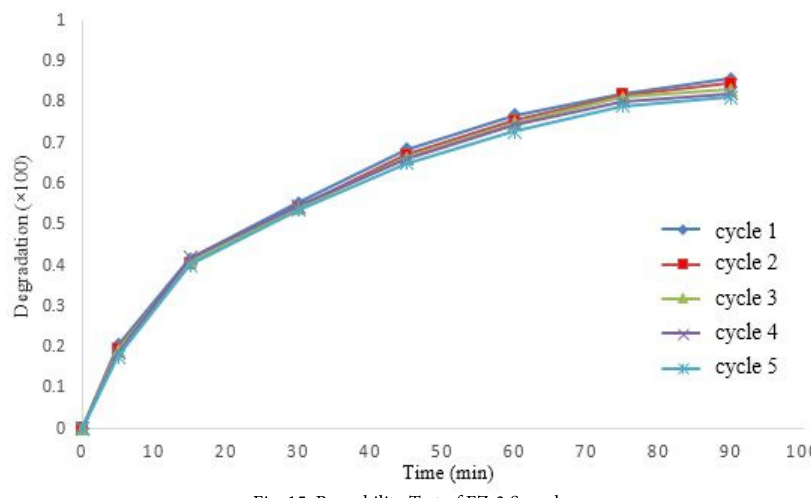
Fig. 15. Reusability Test of FZ-2